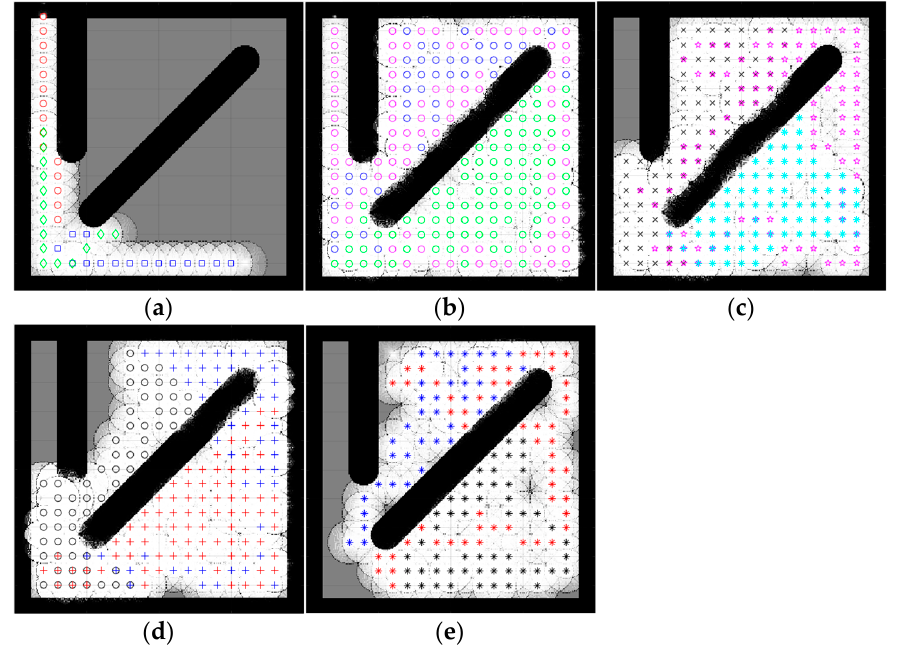
Figure 9. Percentage of the explored area after implementing the CME-SSA and the other approaches on complex map 3. Complex map 3: ( a ) CME, 36.48% (Iteration 15); ( b ) CME-SSA, 98.49%; ( c ) CME-GWO, 90.51%; ( d ) CME-GWOSSA, 86.32%; ( e ) CME-SCA, 78.44%.